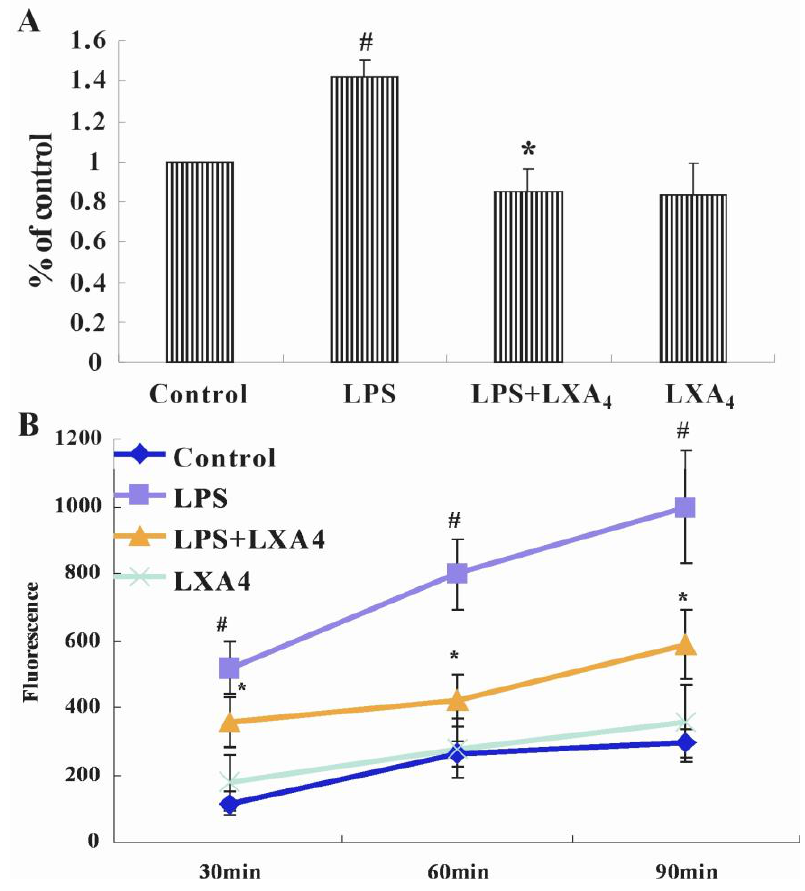
FIGURE 6. Effect of LXA Intracellular ROS was evaluated with fluorometric assay employing DCFH- DA. (B) Extracellular H 0.05 compared to control cells. * p < 0.05 compared to cells treated by LPS